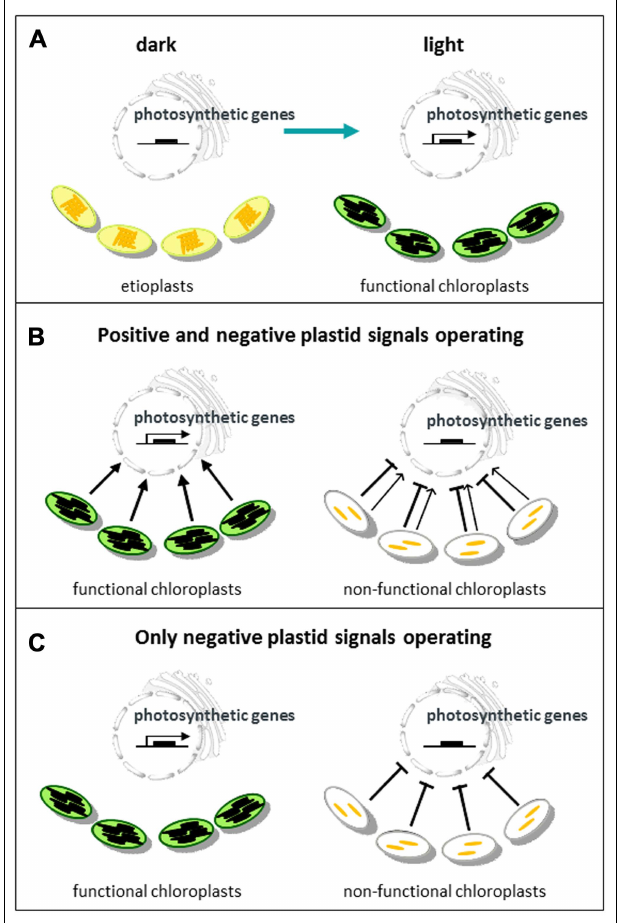
FIGURE 1 | Models for communication between plastids and the nucleus. (A) During chloroplast biogenesis light promotes the synthesis of many nuclear-encoded proteins required for the development of etioplasts into functional chloroplasts. (B) Under normal conditions a positive plastid signal provides information on the developmental status of the chloroplast and promotes nuclear gene expression. Chloroplast damage or loss of function leads to a reduction in the positive signal (in most conditions) and an additional inhibitory signal. (C) The alternative model in which only an inhibitory plastid signal resulting from chloroplast damage or loss of function provides information, but there is no feedback from the chloroplast to the nucleus under normal